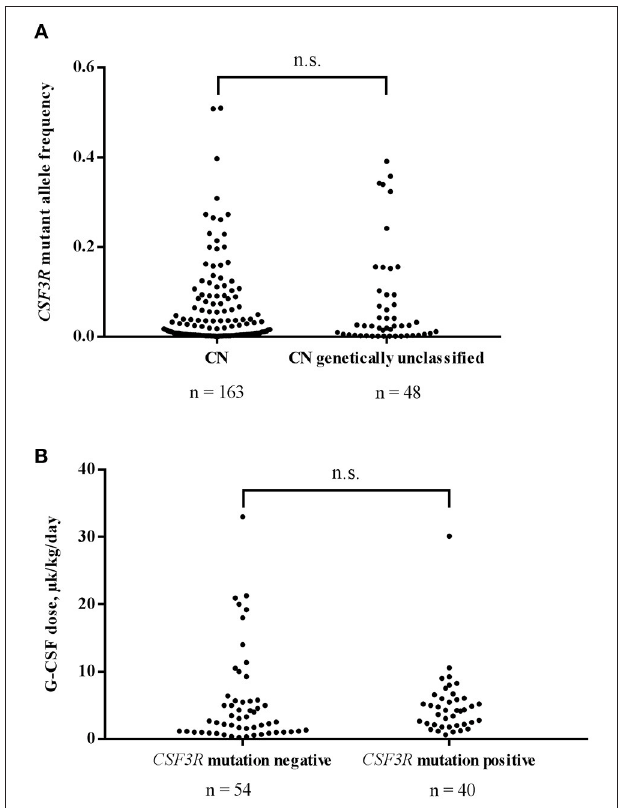
FIGURE 2 | (A) Comparison of CSF3R mutant allele frequencies in CN and genetically unclassified CN patients. No significant difference in MAF of CSF3R mutations between CN ( n = 163) and genetically unclassified CN ( n = 48) groups was observed; n.s.- not significant. (B) The acquisition of CSF3R mutations is not associated with higher rhG-CSF doses. Patients were divided into 2 groups based on the presence ( n = 40) or absence ( n = 54) of CSF3R mutations detected by cDNA deep-sequencing. rhG-CSF doses at the time of sample collection are plotted for the both groups; n.s., not